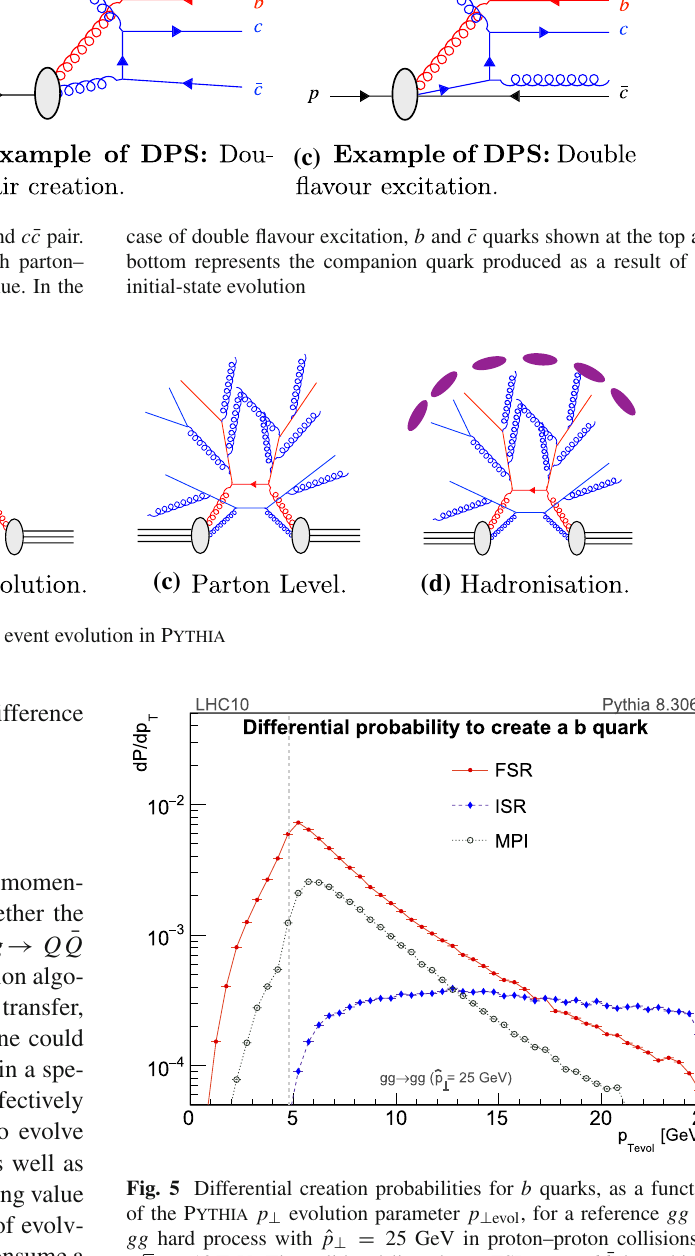
Fig. 5 Differential creation probabilities for b quarks, as a function of the Pythia p ⊥ evolution parameter p ⊥ evol , for a reference gg → gg hard process with ˆ p ⊥ = 25 GeV in proton–proton collisions at √ s = 10TeV. The solid red line shows FSR g → b ¯ b branchings, the dashed blue one shows ISR gluons backwards-evolving to b quarks, andthedottedblackoneshowsMPIpair-creationandflavour-excitation processes. The vertical dashed gray line indicates the default value of the b quark mass in Pythia , m b = 4 .